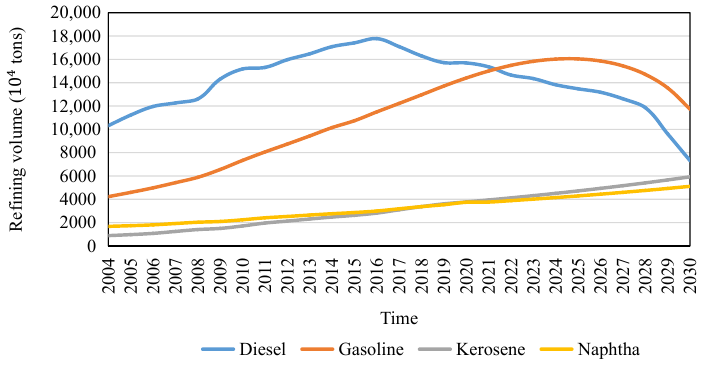
Figure 13. Refining volume of petroleum industry simulated until the year 2030.